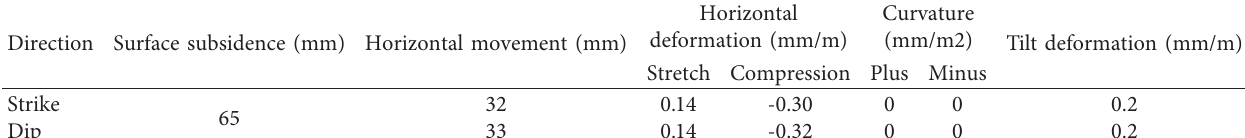
Table 2: Prediction of maximum surface movement and deformation in 8103 filling mining face.